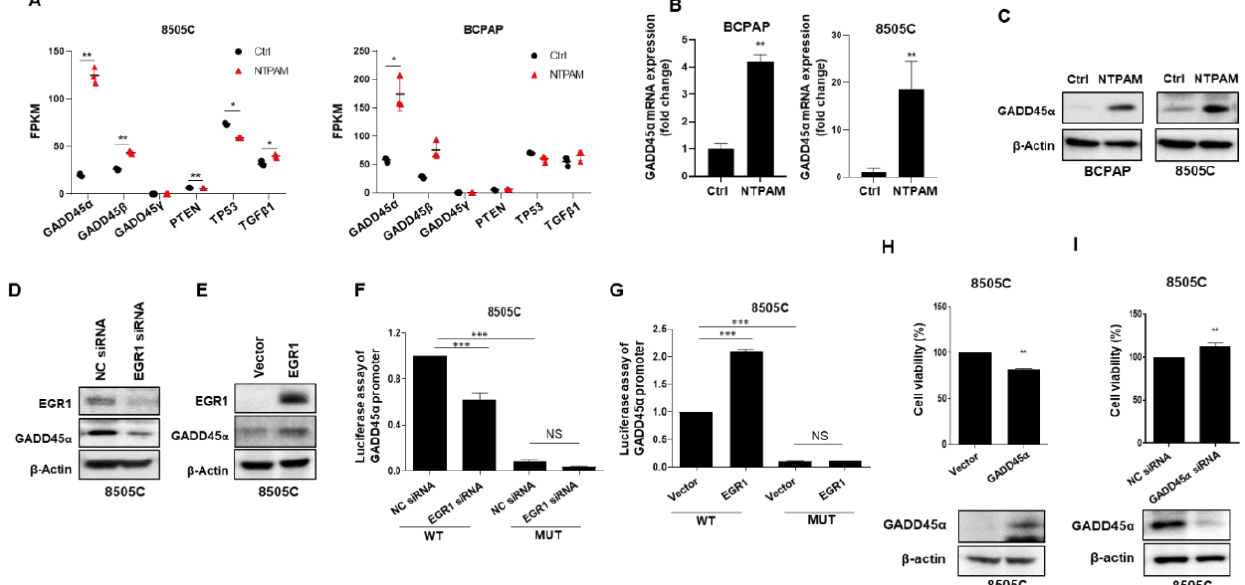
Figure 6. NTPAM induces cell death through the ROS/EGR1/GADD45α pathway in THCA cells. ( A ) Changes in the expression of EGR1 target genes after NTPAM treatment, as determined by RNA-seq. Results were analyzed using inde- pendent t -test. After treatment of BCPAP and 8505C cells with 2 h dose-NTPAM for 24 h, GADD45α was examined using qPCR analysis ( B ) and western blot analysis ( C ). Results were analyzed using Mann-Whitney U test. Cells were transfected with EGR1 siRNA ( D ) or the EGR1 overexpression vector ( E ) for 48 h, followed by western blot analysis. EGR1 siRNA ( F ) or the EGR1 overexpression vector ( G ) was co-transfected with the wild-type GADD45α promoter or the mutant GADD45α promoter P-2/3m into 8505C cells. At 24 h after transfection, cells were lysed, and luciferase activity was meas- ured using a luminometer (FilterMax F5). Results were analyzed non-parametric one-way ANOVA followed by Dunnett’s post-hoc test. 8505C cells were transiently transfected with a GADD45α overexpression vector ( H ) or the GADD45α-spe- cific siRNA ( I ) for 48 h. Cell viability was evaluated using the WST1 assay. Results were analyzed using Mann-Whitney U test. Each figure is representative of three independent experiments. Data were expressed as mean ± standard deviation of the mean (±SD). Differences were considered relevant at p < 0.05 (* p < 0.05, ** p < 0.01, *** p < 0.001).